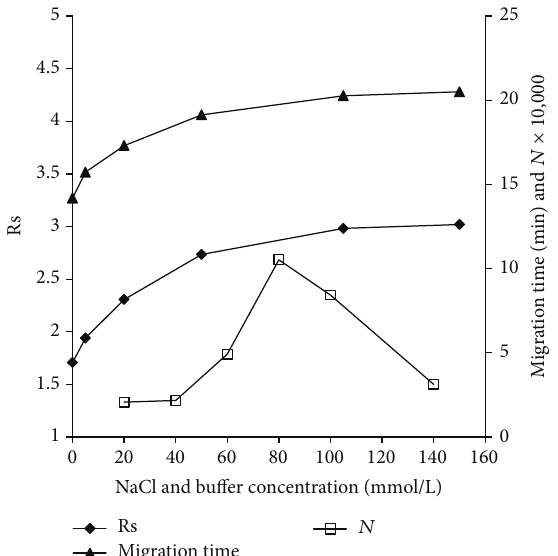
Figure 2: Influence of buffer concentrations on theoretical plate numbers, influences of NaCl concentration on Rs and migration times.